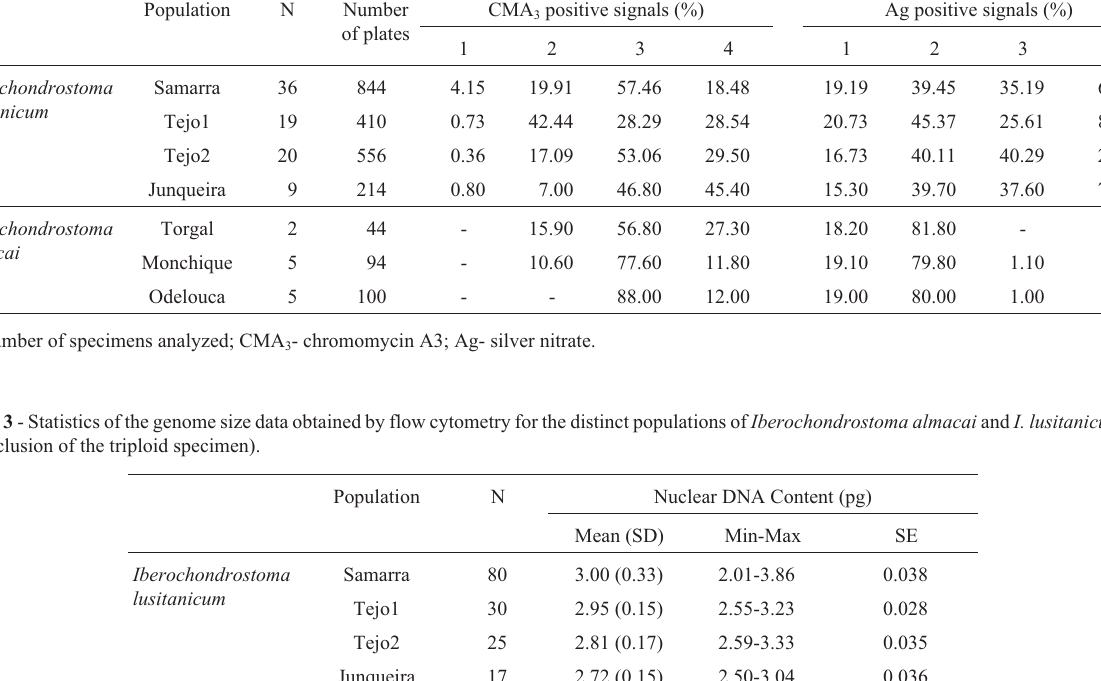
Table 2 - Variation (percentage of occurrence) in the number of CMA 3 - and Ag-positive NORs in Iberochondrostoma species. Population